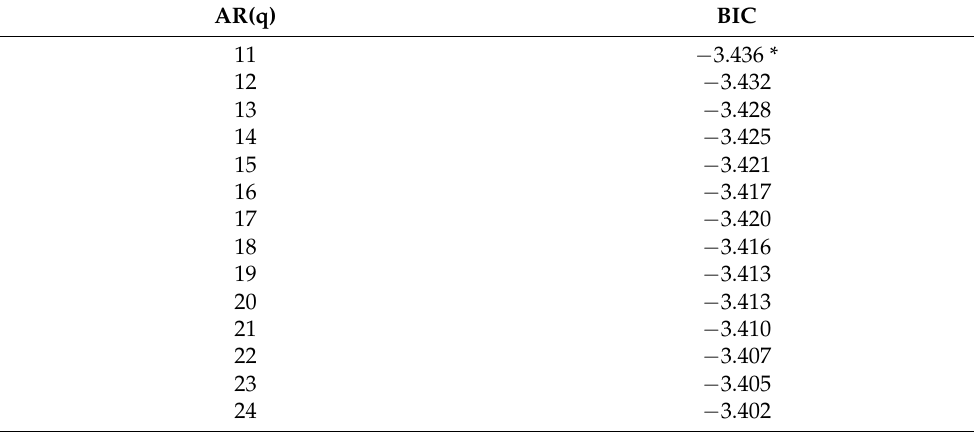
Table 1. Bayesian information criterion for different AR(q) models (The model with the lowest BIC is preferred; the matching BIC statistic is marked with an asterisk). Bayesian information criterion for different AR(q) models. The AR(11) model is the one that minimizes the BIC, while the matching BIC statistic is marked with an